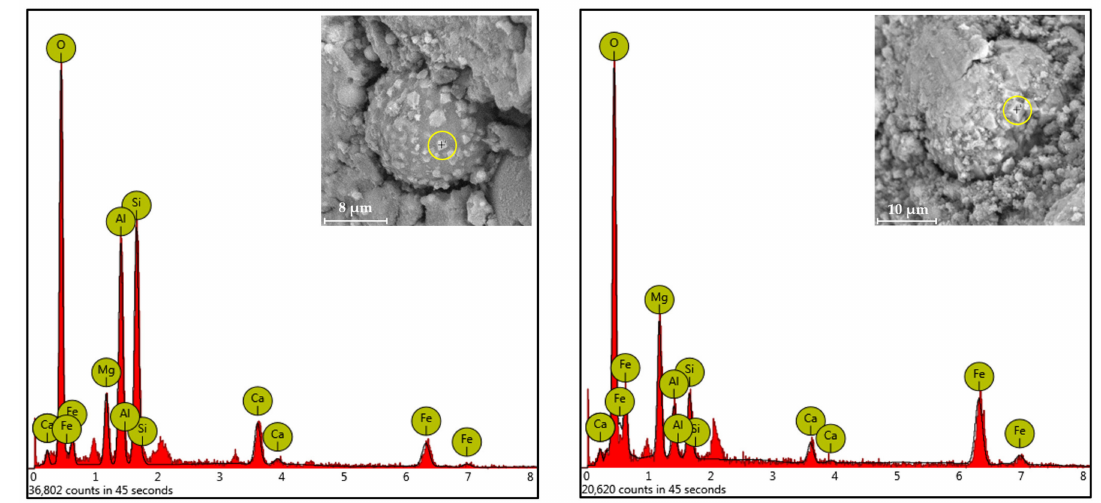
Figure 3. EDX analysis of the mineral phases on the geopolymer with ( a ) B. subtilis ; ( b ) B. sphaericus .